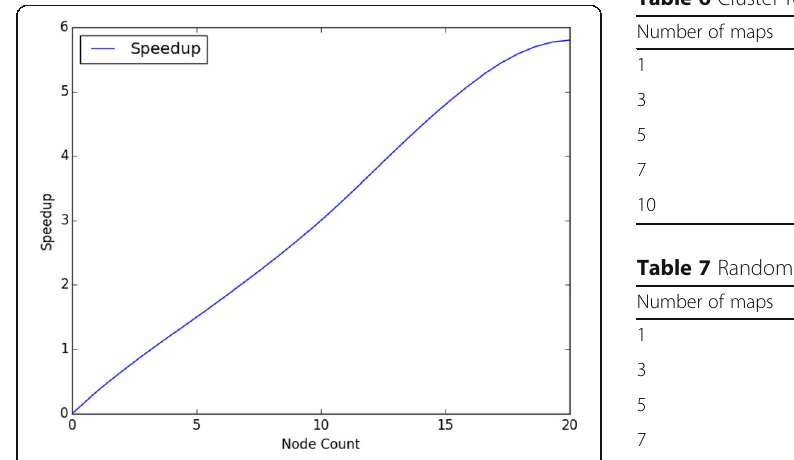
Fig. 6 Graph of speedup against number of nodes